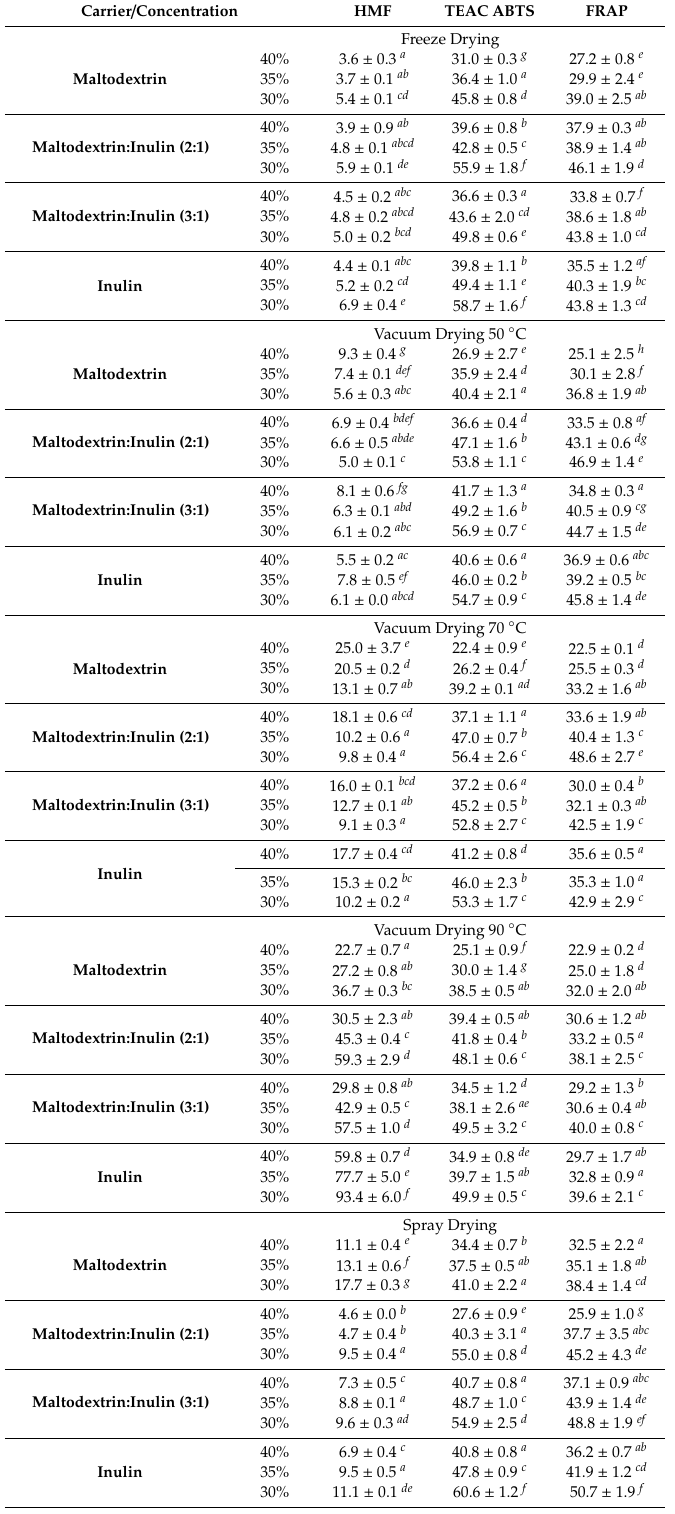
Table 4. The content of hydroxymethyl- l -furfural ( µ g / kg db) in, and the antioxidant capacity (mmol Trolox equivalent / kg db) of, blackcurrant juice powders made with the addition maltodextrin, inulin, and a mixture of maltodextrin–inulin using di ff erent drying methods (average ± SD; n =